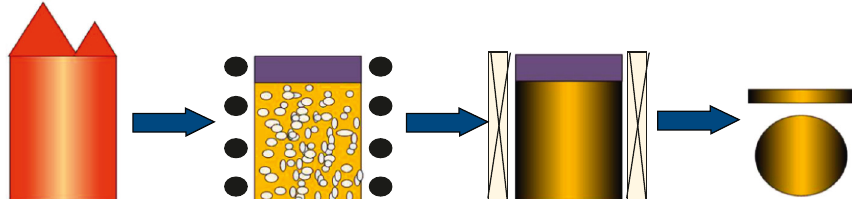
Figure 22: Flowchart for the preparation of CuCr alloy by aluminothermic reduction-magnetoelectric coupling refining-water and gas composite cooling